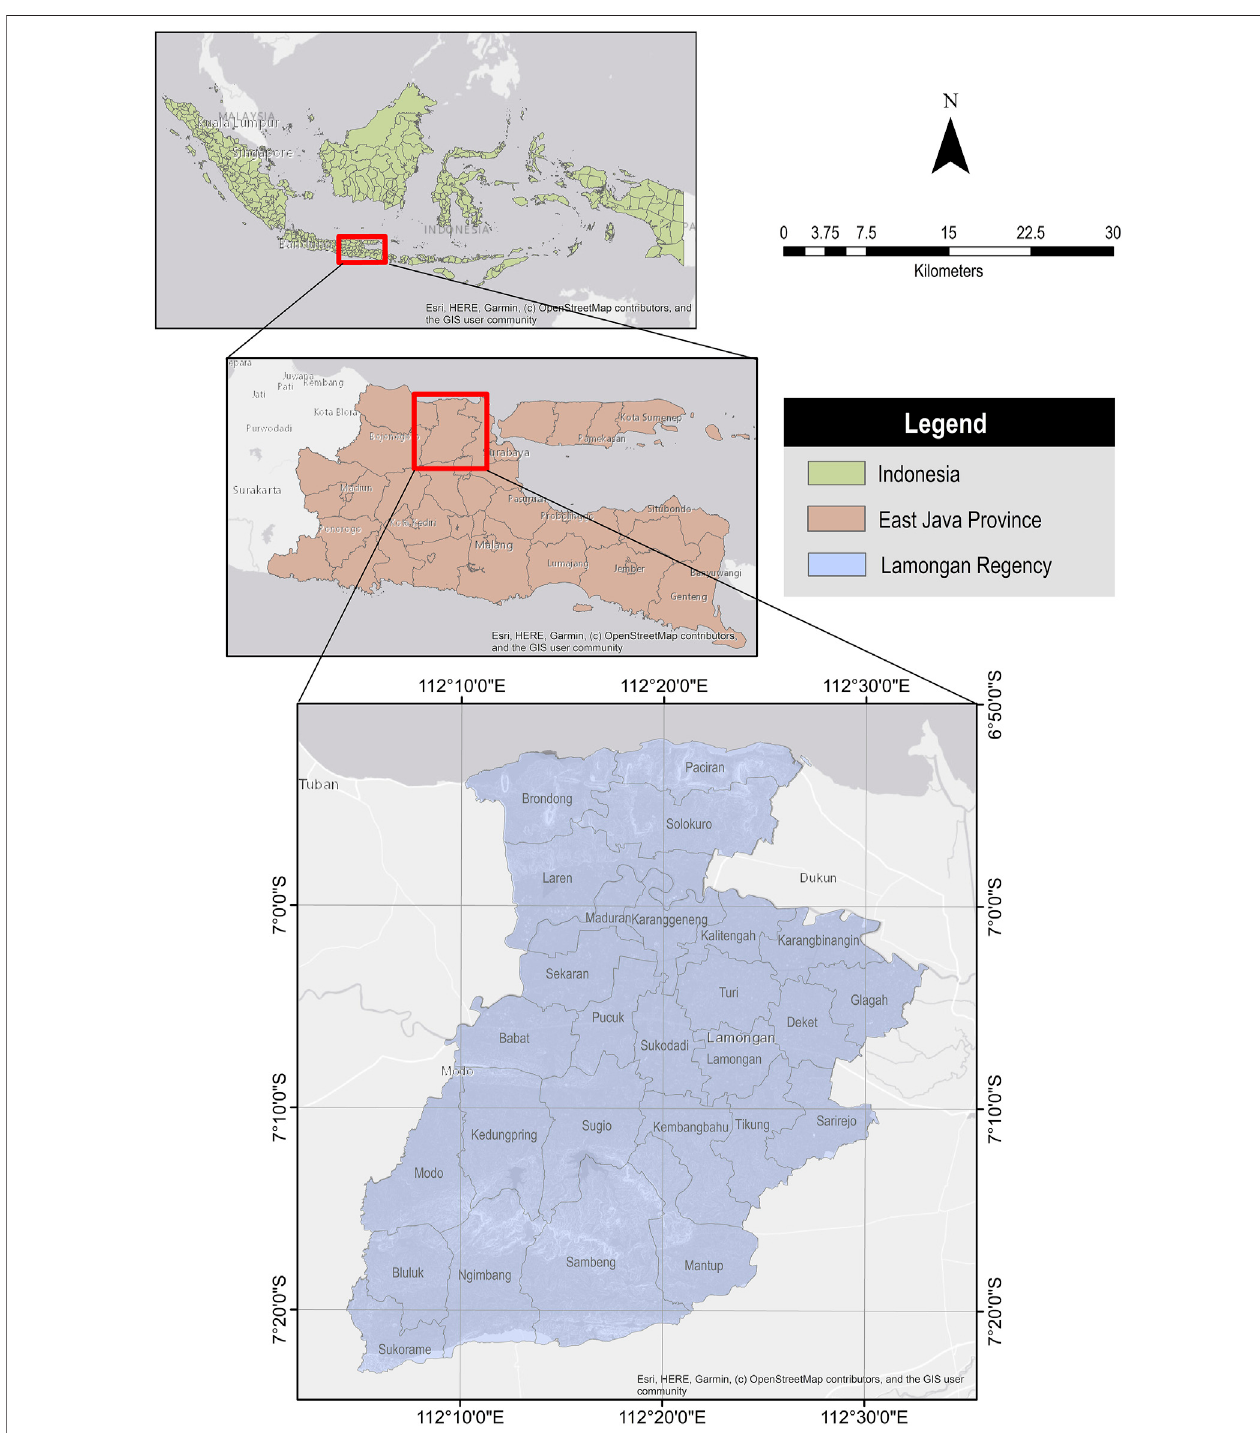
FIGURE 1 | The study area